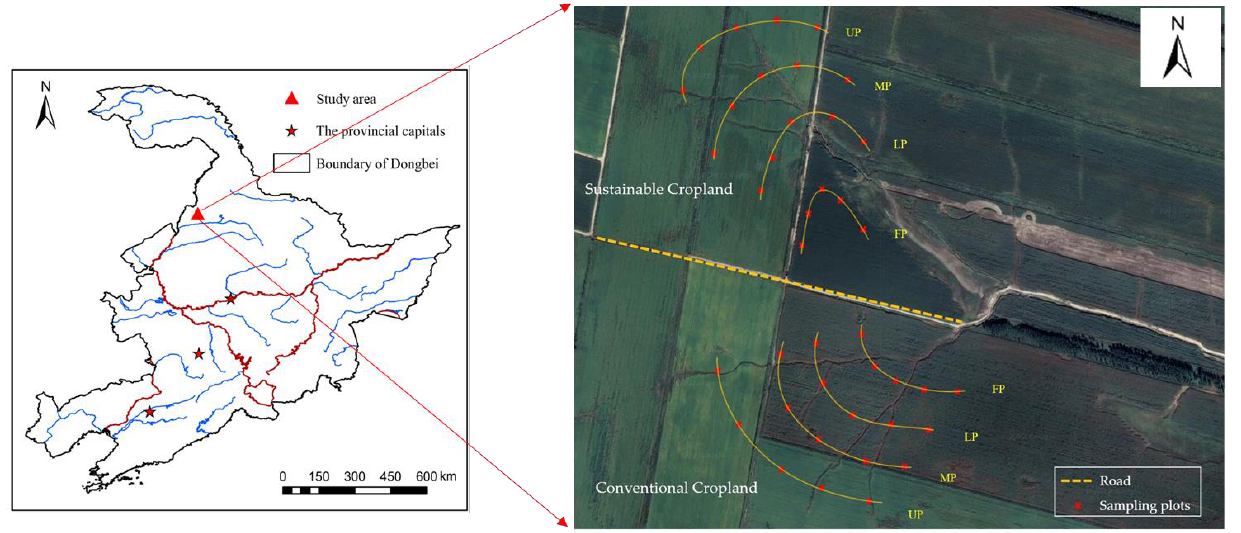
Figure 1. Location of the study site in the black soil region of Northeast China. Distribution of sampling plots in sustainable cropland and conventional cropland. UP: upper slope position; MP: middle slope position; LP: lower slope position; FP: footslope position.